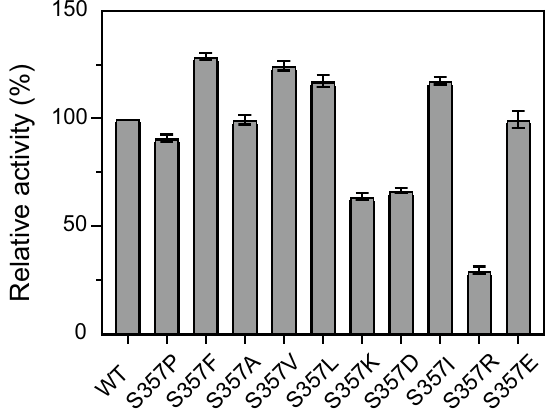
Fig. 2 Preliminary screening of the activities of dextranase AoDex and its mutants